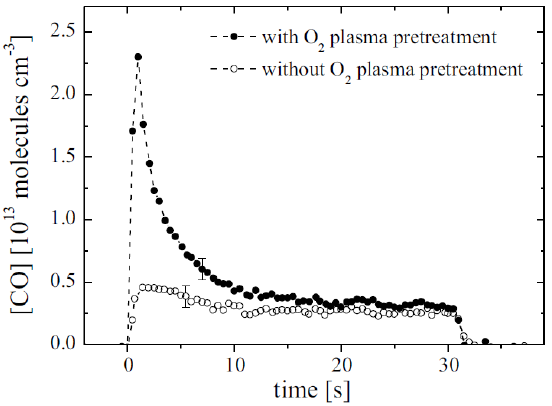
Figure 16. Time dependent CO concentration with and without O 2 plasma pretreatment (CF 4 plasma, φ = 12 sccm, p = 1.6 Pa). (Pretreatment: t = 3 min, p = 1.3 Pa, P = 1.5 kW, φ O2 = 30 sccm) [58], © Springer Publishing. Reproduced with permission. All rights reserved.